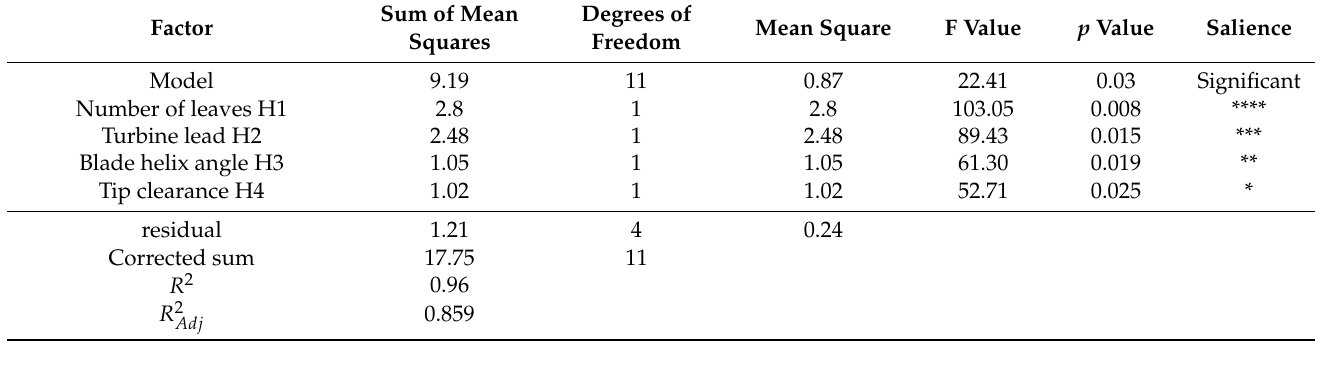
Table 5. Significance table of experimental factors of significant influencing factors.